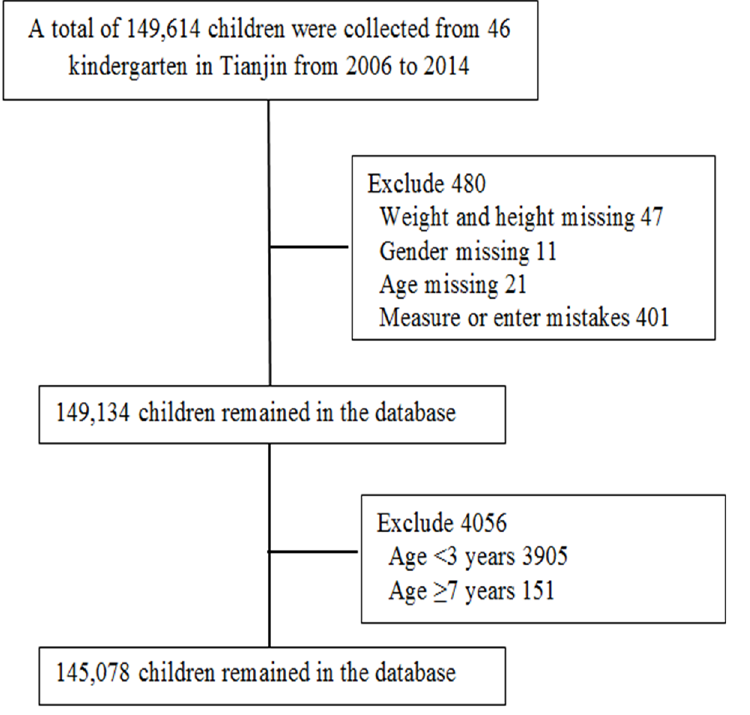
Fig 1. Detailed flow chart for data cleaning